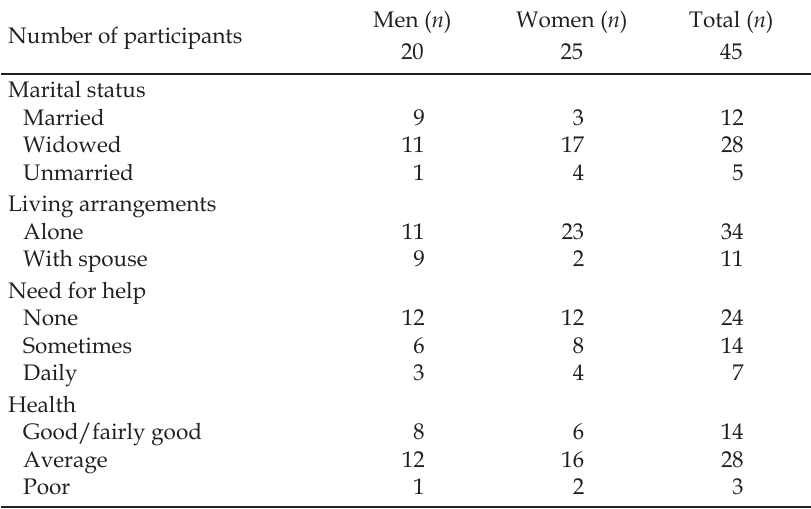
Table 1. Characteristics of participants in the interviews ( n =